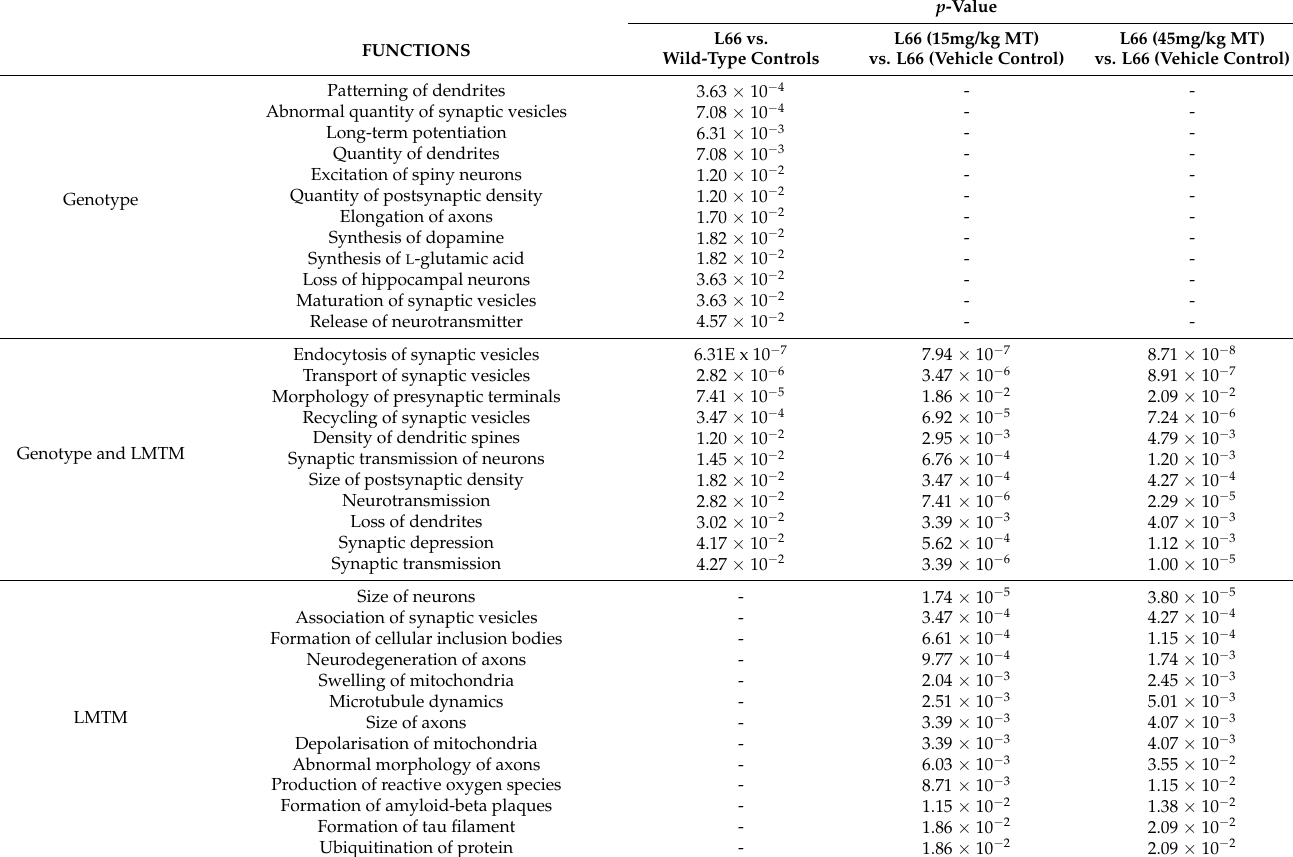
Table 1. Summary of significant hits for cellular functions identified using IPA Core Analysis. The cellular functions are significantly altered due to tau overexpression, to LMTM treatment or both. Significant alterations were found by comparing our proteomics data with the Ingenuity Knowledge Base. The cellular functions are named and corresponding p -values are